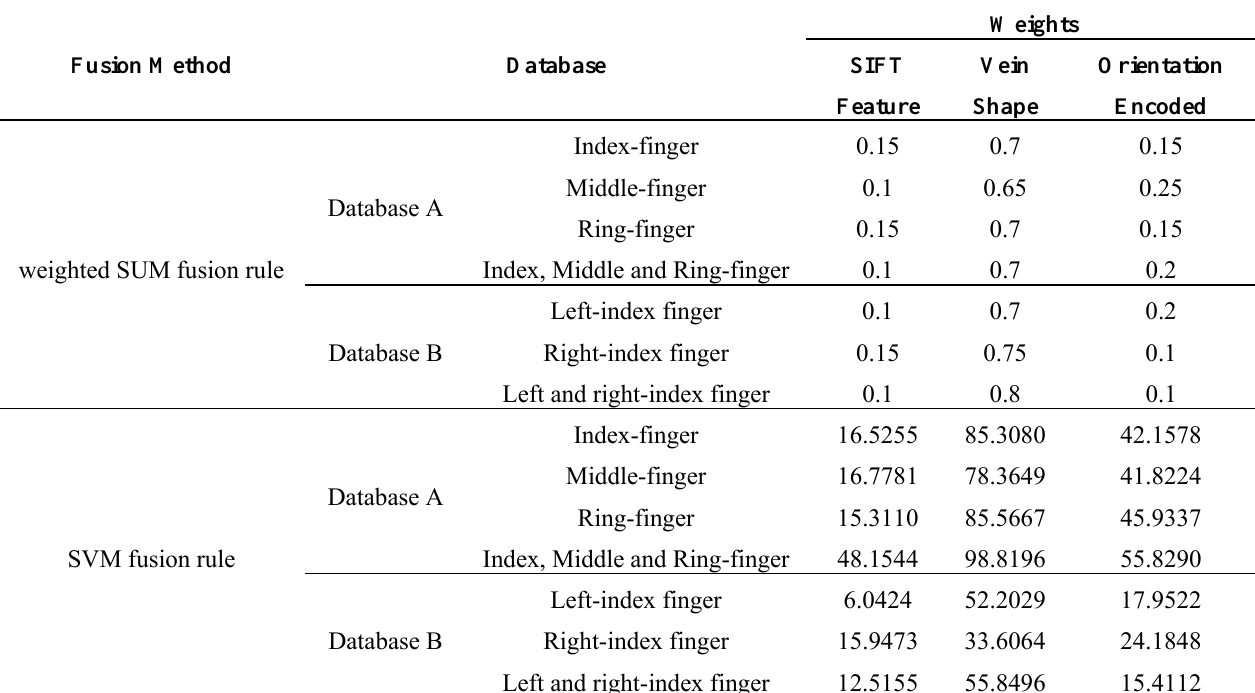
Table 3. Weights of SUM fusion rule and SVM for two databases.